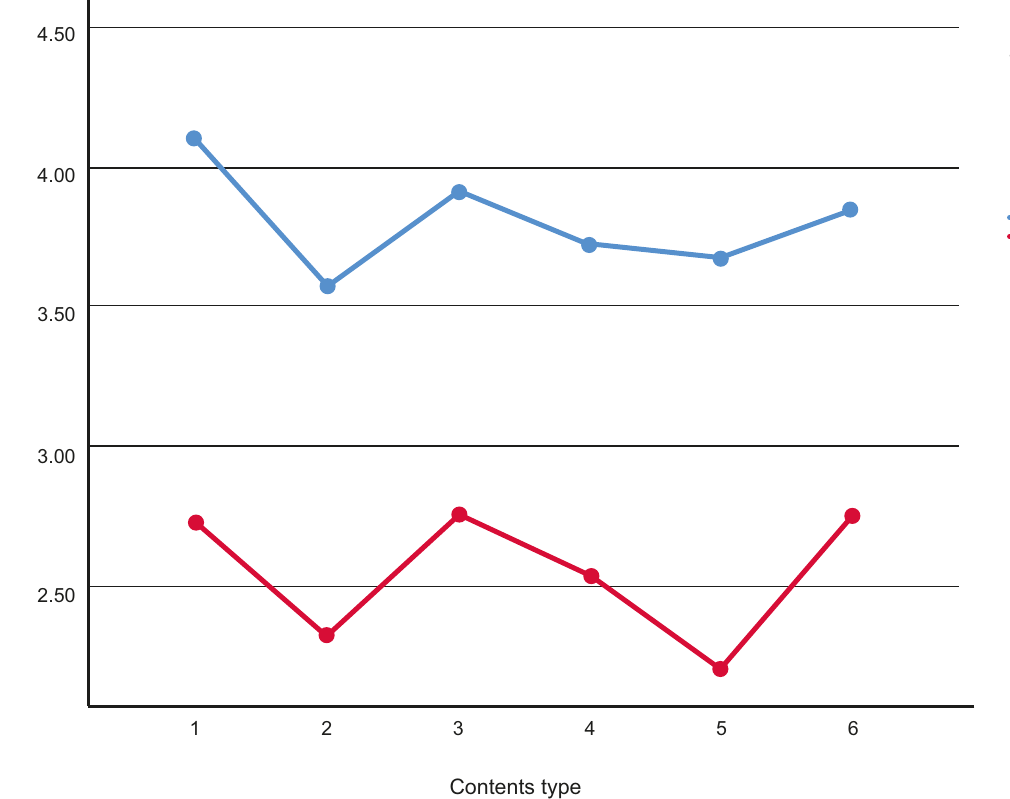
Fig 1. Interaction effect of content type and experience of difficult/dangerous on-road situation due to distraction from roadside advertisement. Types of contents: 1- Sexual, 2- Positive, 3- Negative, 4- Humorous, 5- Sales offers, 6- Intriguing.